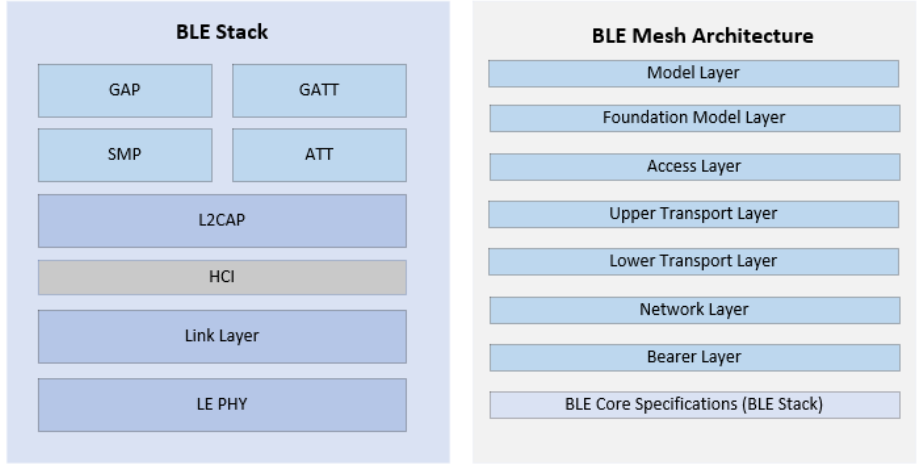
Figure 1. BLE stack and mesh architecture